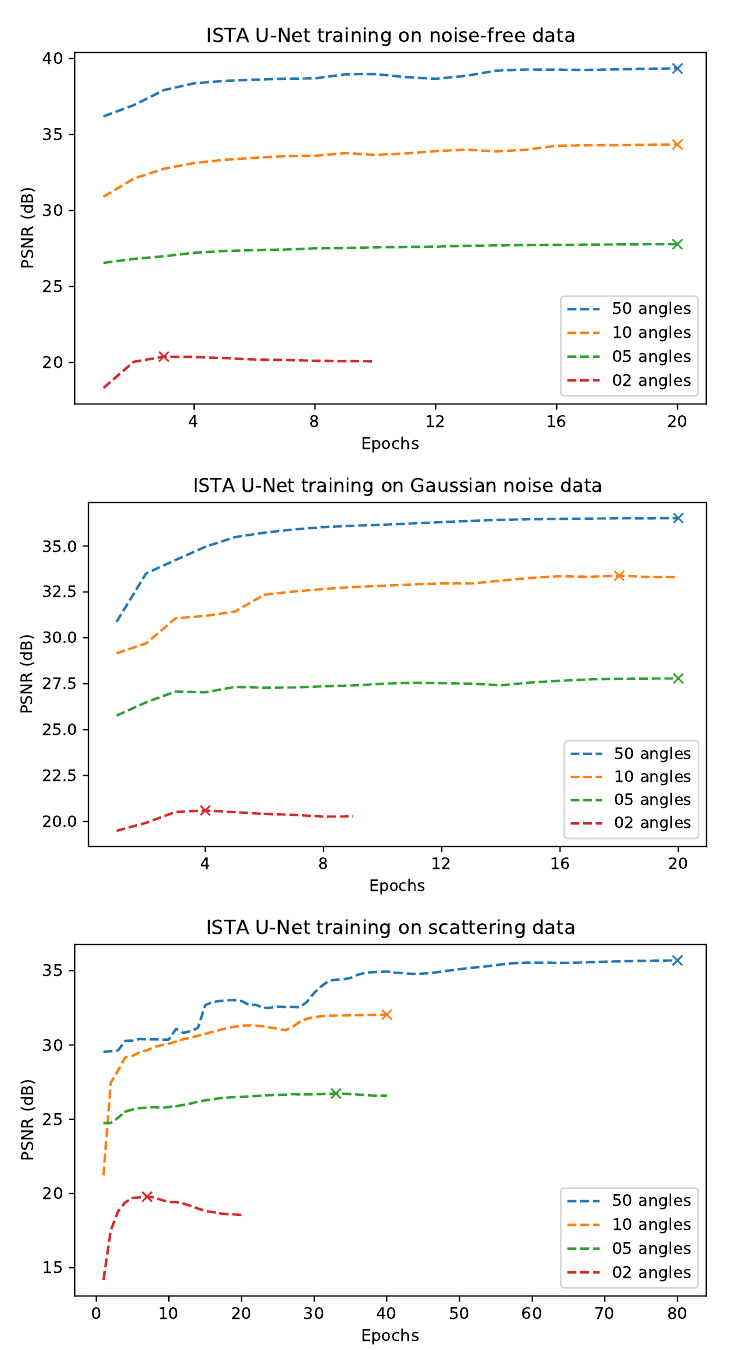
Figure A11. Training curves of ISTA U-Net on the Apple CT dataset. Dashed lines: average validation PSNR in decibel computed after every full training epoch; marks: selected model. Duration of 20 epochs on full dataset: ≈ 10 days for hidden layer width 32+ and 5 scales, respectively ≈ 5.5 days for hidden layer width 16+ and 6